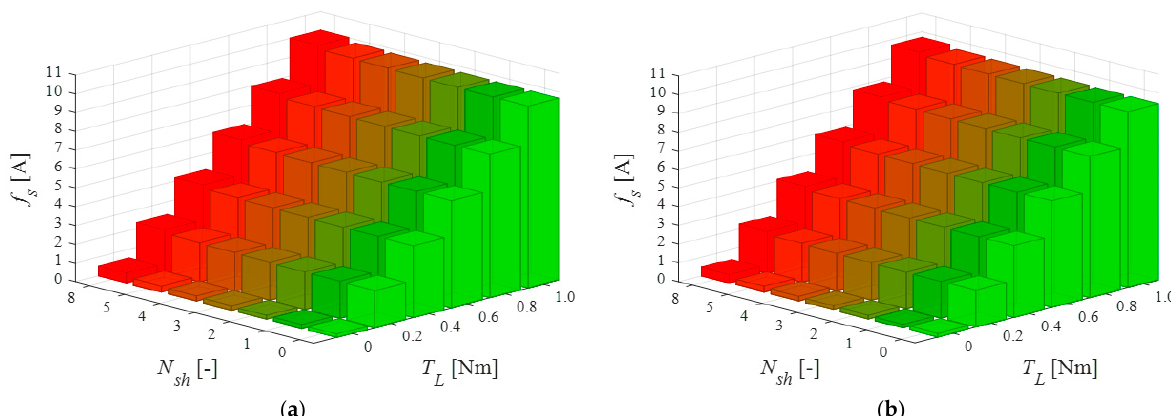
Figure 11. Dependence of the fundamental harmonic of the stator current amplitude, f s , on the number of shorted turns and the load torque values for f s = 100 Hz: scalar control ( a ), field-oriented control ( b ).